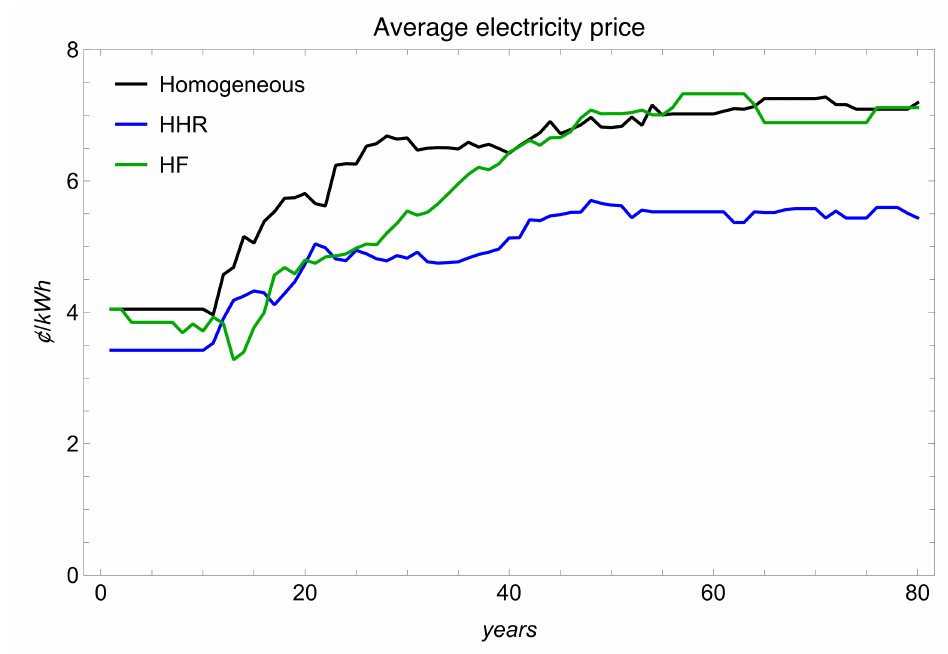
Figure 5. Average electricity prices for the homogeneous case, HHR case, and HF